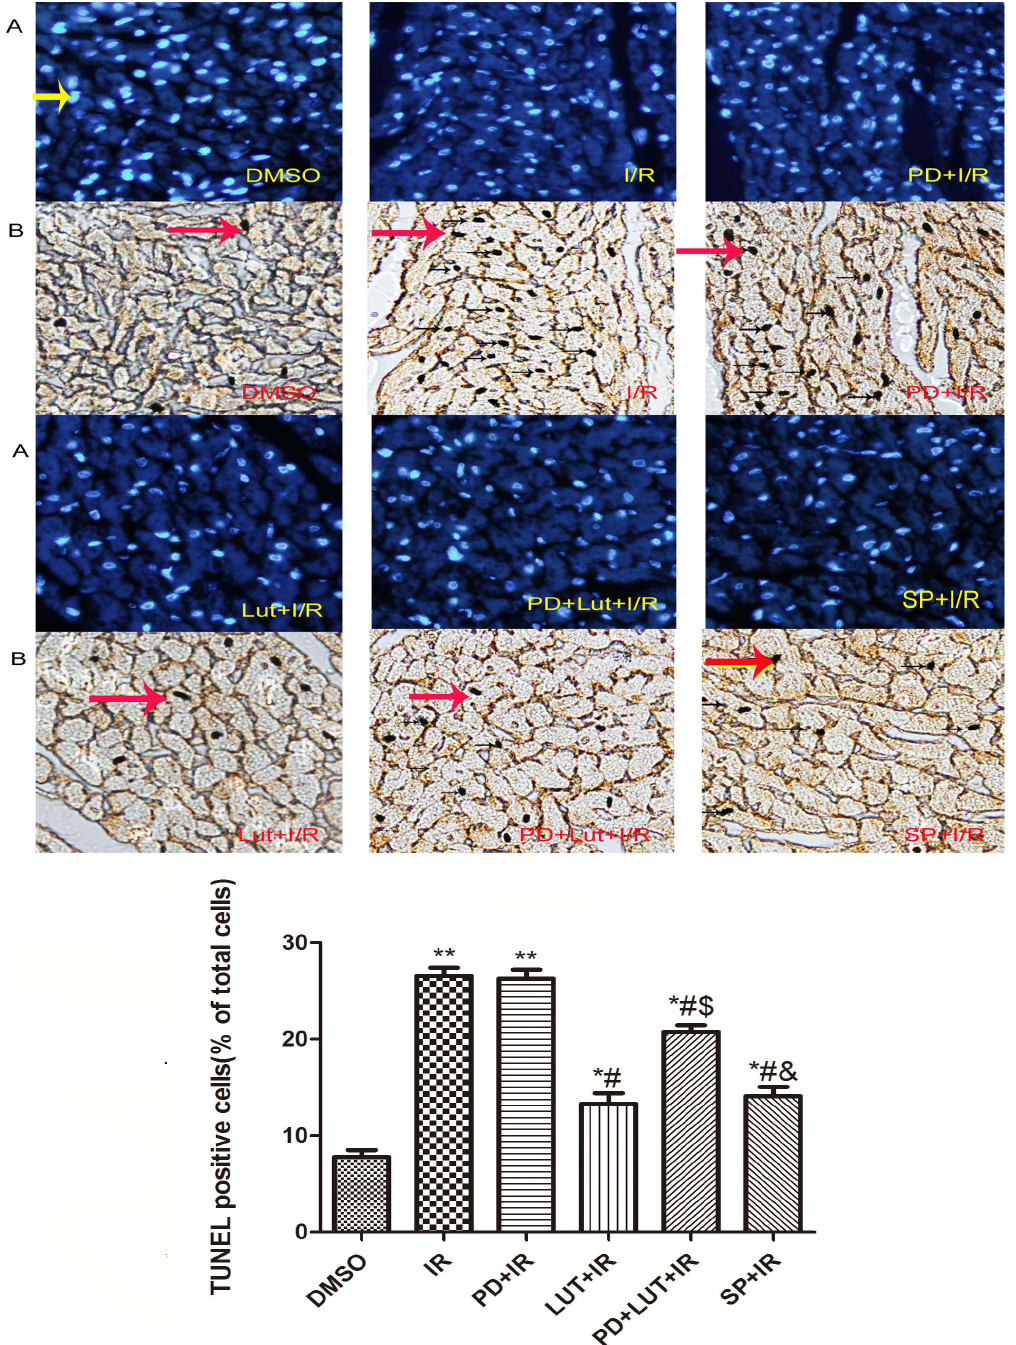
Figure 3. Apoptosis of each group. A representative photomicrograph of a TUNEL (B) and DAPI-stained (A) cardiomyocytes were showed. After 2 h reperfusion, the heart tissure were sectioned for analysis of anti-apoptotic effect of luteolin and SP600125 by TUNEL staining. The results are expressed as the mean 6 SEM, n=3. # P , 0.05 versus I/R; $ P , 0.01 versus I/R + Lut (40 m M), & P , 0.05 versus I/R + Lut(40 m mol/L) + PD (20 m mol/L). Cells were examined by light microscopy (200 6 magnification). Yellow allow indicate DAPI-stained nucleus, red allows indicate TUNEL- positive caryons.